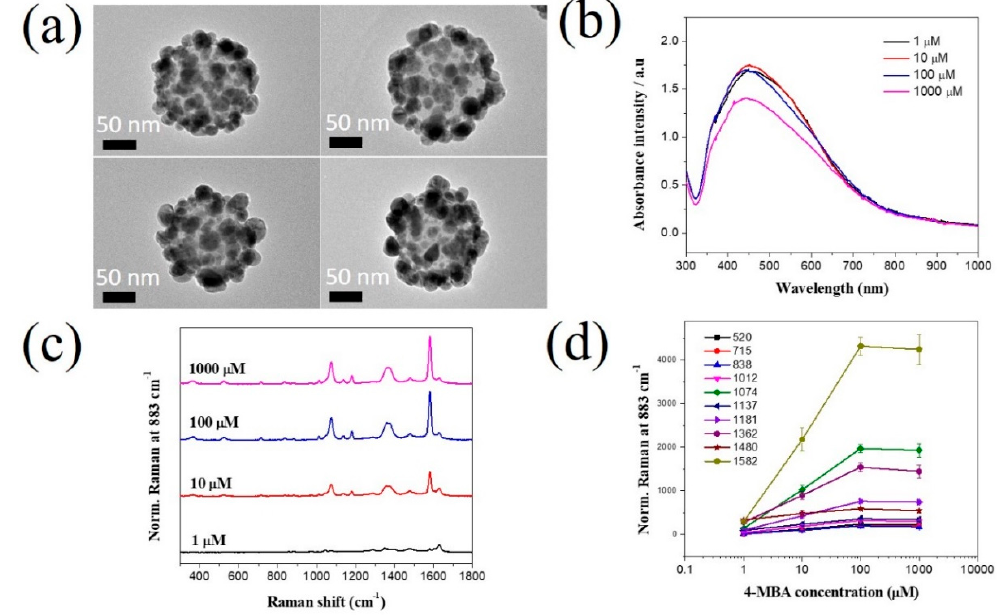
Figure 3. Effect of 4-MBA on SERS signal of SiO 2 @Au@4-MBA@Ag NPs at different concentrations in the range of 1 µM–1000 µM. ( a ) TEM images, ( b ) UV-Vis spectra, ( c ) Raman spectra, and ( d ) Raman signal plot of SiO 2 @Au@4-MBA@Ag. Error bar represents samples in